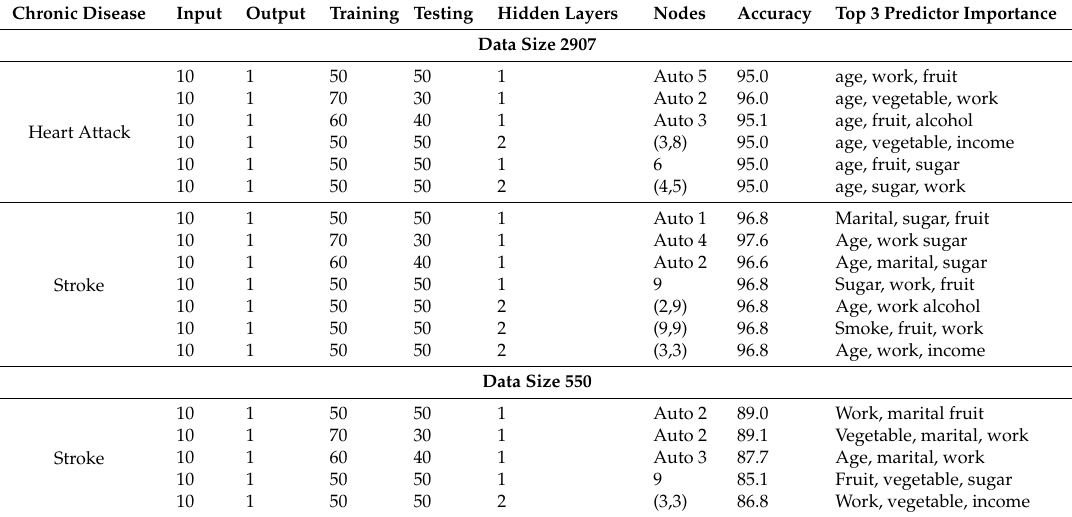
Table 2. Summary of Neural Network analyses.